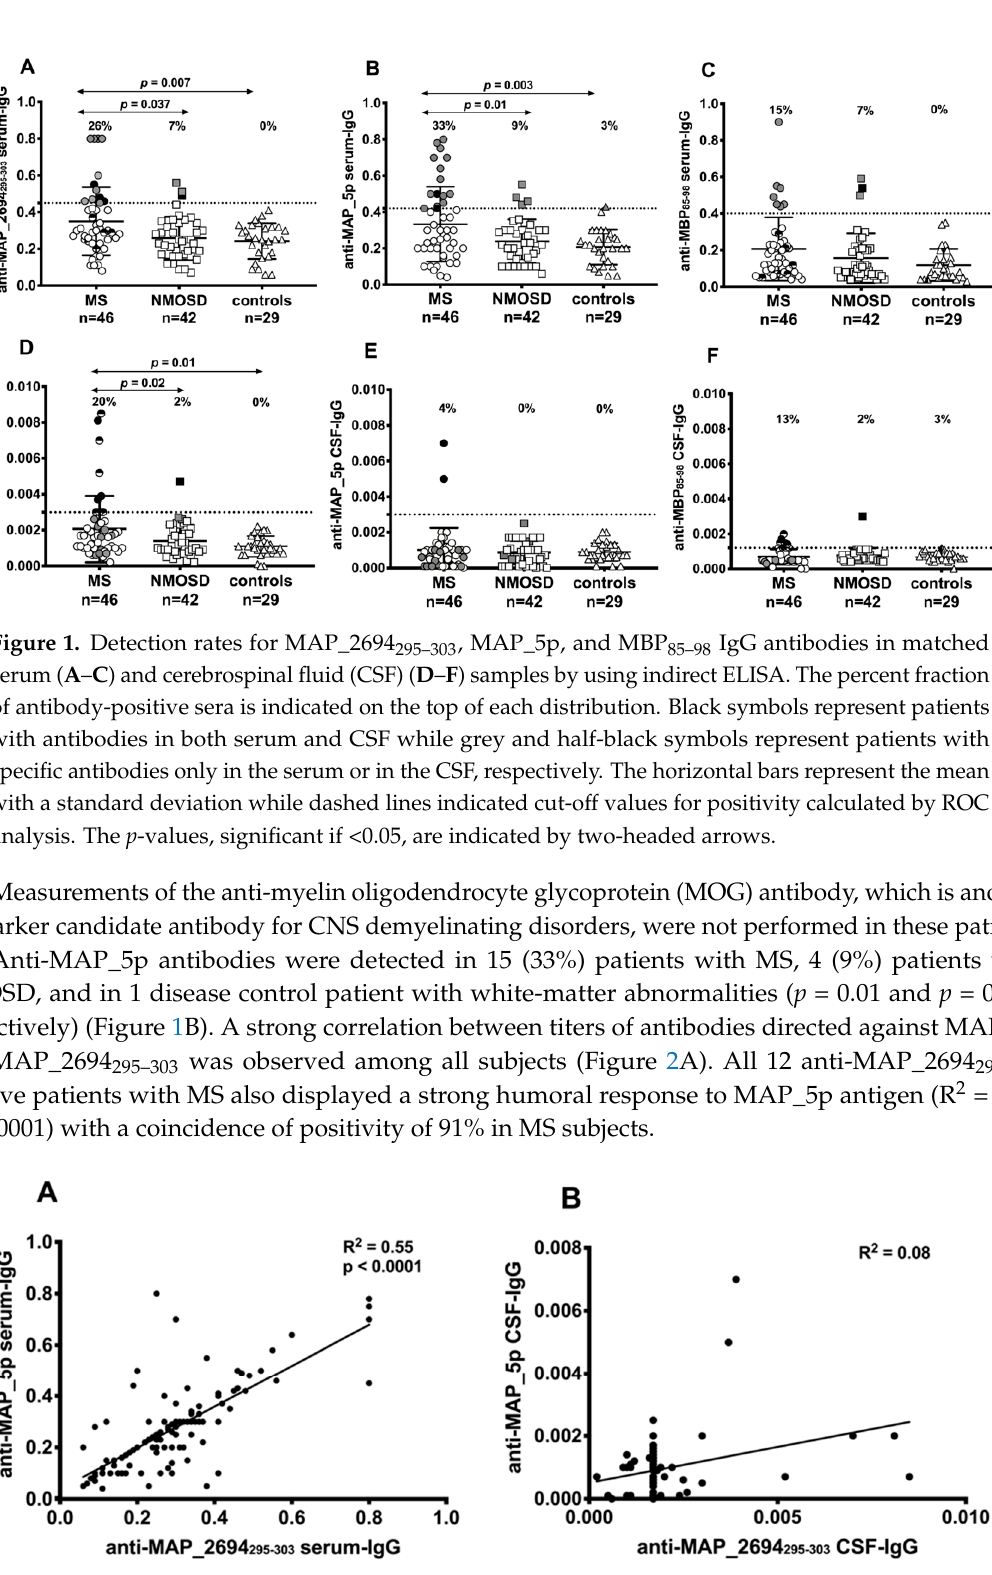
Figure 2. Correlations between antibodies recognizing MAP_2694 295–303 and MAP_5p antigens. The distributions represent correlation between antibodies against the mycobacterial peptides detected in the serum ( A ) or CSF ( B ) of all 116 study subjects. Each circle represents the titer for one patient. Among the 4 antibody-positive patients with NMOSD, 2 were AQP4-negative and 2 were